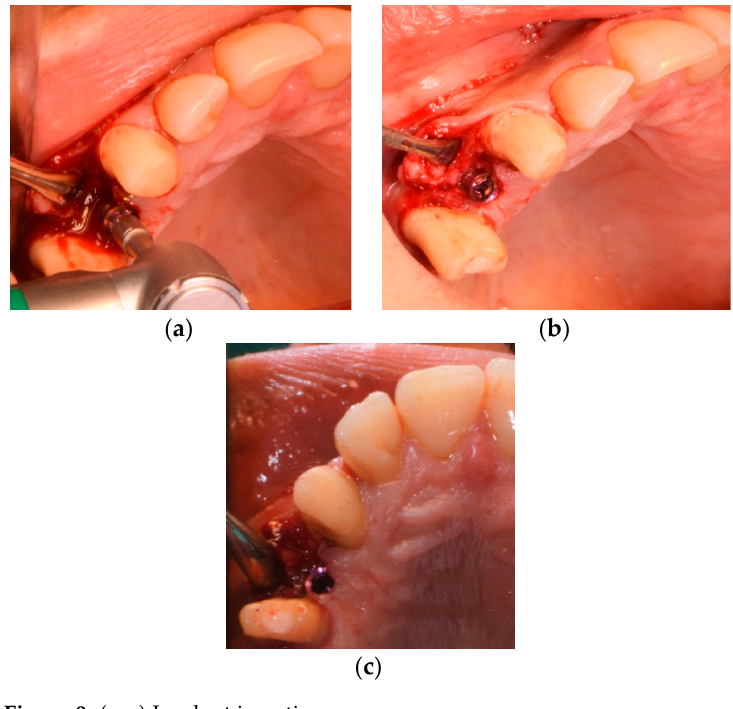
Figure 9. ( a – c ) Implant insertion.